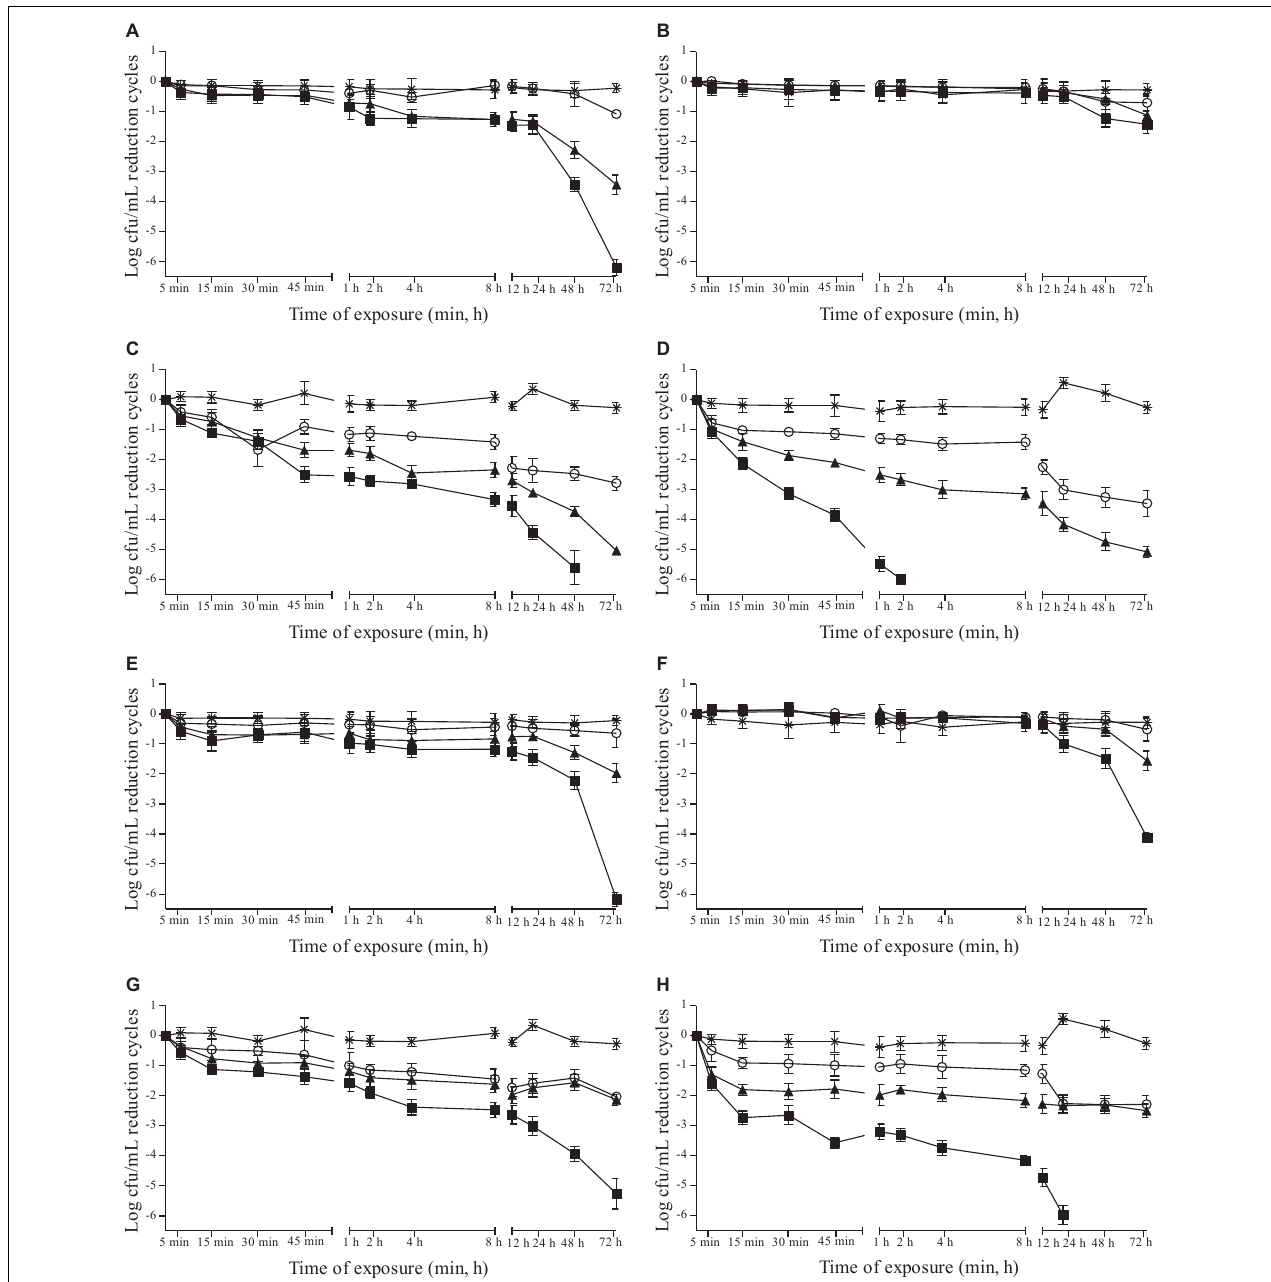
FIGURE 2 | Reduction cycles (log cfu/mL; n = 6) of the counts of C. albicans ATCC 90028 (A,E) , C. tropicalis ATCC 28707 (B,F) , P. anomala ATCC 40101 (C,G) and S. cerevisiae ATCC 2601 (D,H) in guava juice at 4 ± 0.5 ◦ C as a function of the concentration of M. spicata L. essential oil (A–D) at ( (cid:4) ): 3.75 µ L/mL, ( (cid:78) ): 1.875 µ L/mL, ( ◦ ): 0.9375 µ L/mL or M. villosa Huds. essential oil (E–H) . ( (cid:4) ): 15.0 µ L/mL, ( (cid:78) ): 7.5 µ L/mL, ( ◦ ): 3.75 µ L/mL, ( ∗ ) control: 0 µ L/mL. Detection limit of the test: 1 log cfu/mL.